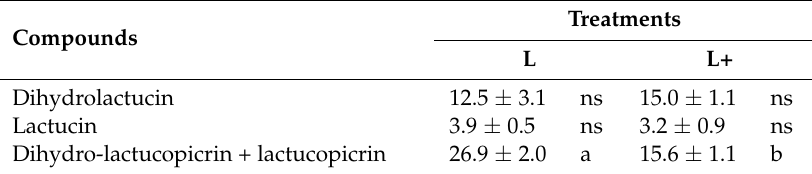
Table 4. Main bitter taste chemical compounds (mg kg − 1 ) in the dry biomasses of monocultured and intercropped lettuce. Different letters indicate significant differences ( p < 0.05) among treatments for each parameter, according to the Tukey’s HSD test. ns = not significant differences.